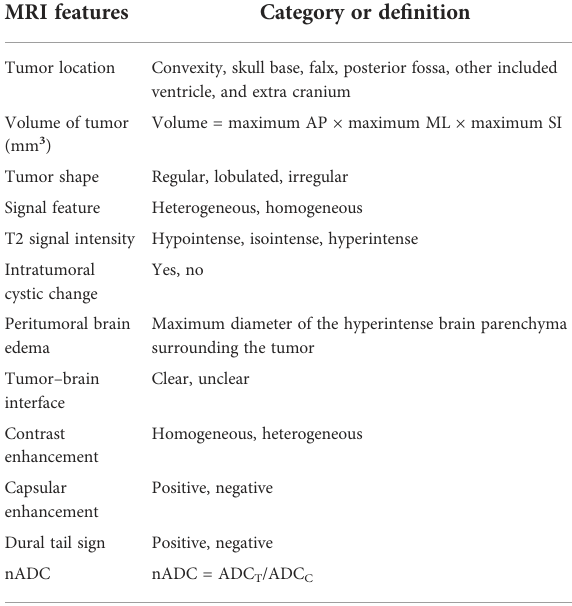
TABLE 1 The de fi nition of radiological features of